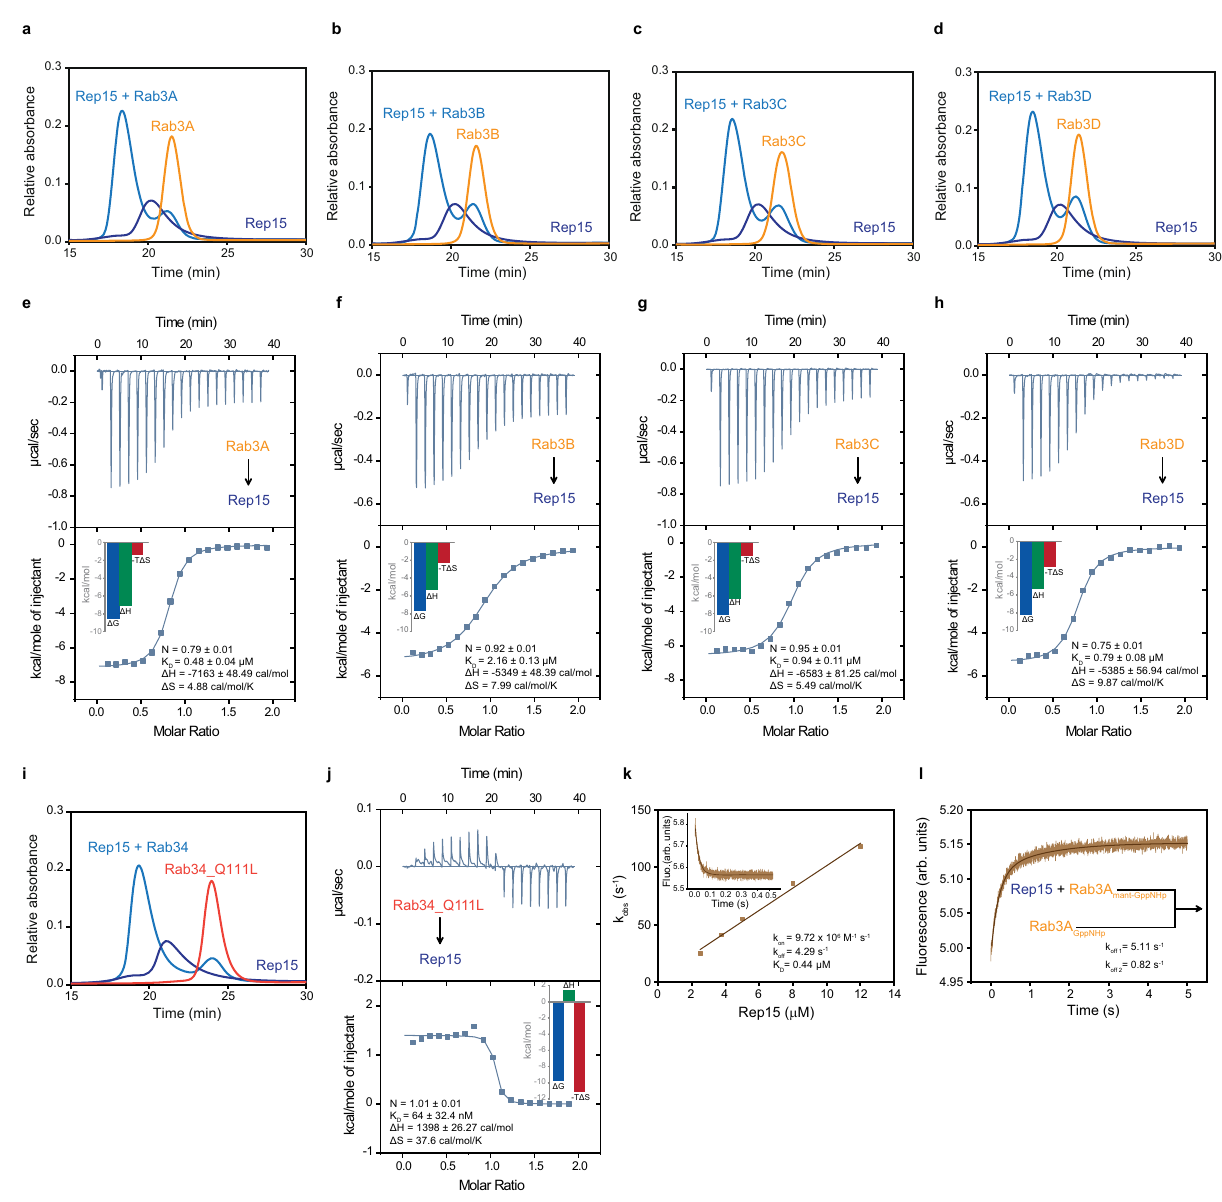
Fig. 3 Quantitative analysis of the Rep15:Rab interaction. a – d The Rep15 protein (110 µ M, blue), the different Rab3 paralogs (121 µ M, orange) and the mixture of both (sky blue) were subjected to an analytical size exclusion chromatography (aSEC) and tested for complex formation. A clear complex formation was detected. The curves shown are representative of at least three experiments. e – h Binding af fi nities were measured by titrating the Rab GTPase (500 µ M) to full-length Rep15 (50 µ M). Integrated heat peaks were fi tted to a one-site-binding model yielding the binding stoichiometry (N), the enthalpy ( Δ H), the entropy ( Δ S), and the dissociation constant (K D ). The data are representative of at least three repetitions. i Interaction of Rep15 (110 µ M, blue) with Rab34 Q111L_1-237 (121 µ M, red) was analyzed by analytical size exclusion chromatography. j ITC analysis of Rab34 Q111L_1-237 (600 µ M) binding to full-length Rep15 (60 µ M). k Association rate constants ( k obs ) for the Rep15 interaction were plotted against the increasing concentration of Rep15 (2 – 14 µ M). Association was monitored by the change in fl uorescence using a stopped- fl ow apparatus at 25 °C. Association of the Rep15 with Rab3A mantGppNHp leads to a decrease in fl uorescence intensity and data is fi tted to a single exponential. The change in fl uorescence of 0.5 μ M Rab3A mantGppNHp upon 3.75 μ M Rep15 binding is shown in the inset. l Dissociation of Rab3A from the Rep15 was determined by monitoring the increase of fl uorescence after mixing a complex of Rep15:Rab3A μ M) with a 25-fold excess of non- fl uorescent Rab3A mantGppNHp (2 GppNHp . Data analyzed are averages of 6 – 8 individual